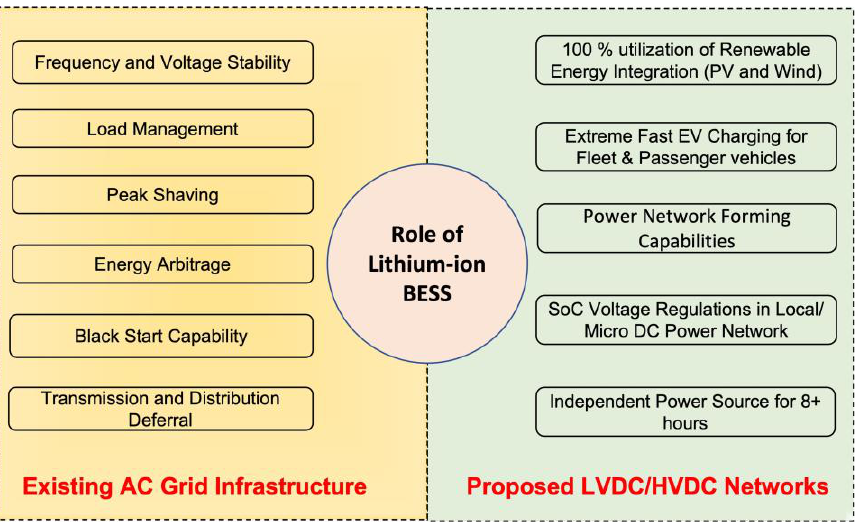
Figure 4. Role of lithium-ion-based battery energy storage systems in existing AC grid infrastructure vs. proposed DC power networks.